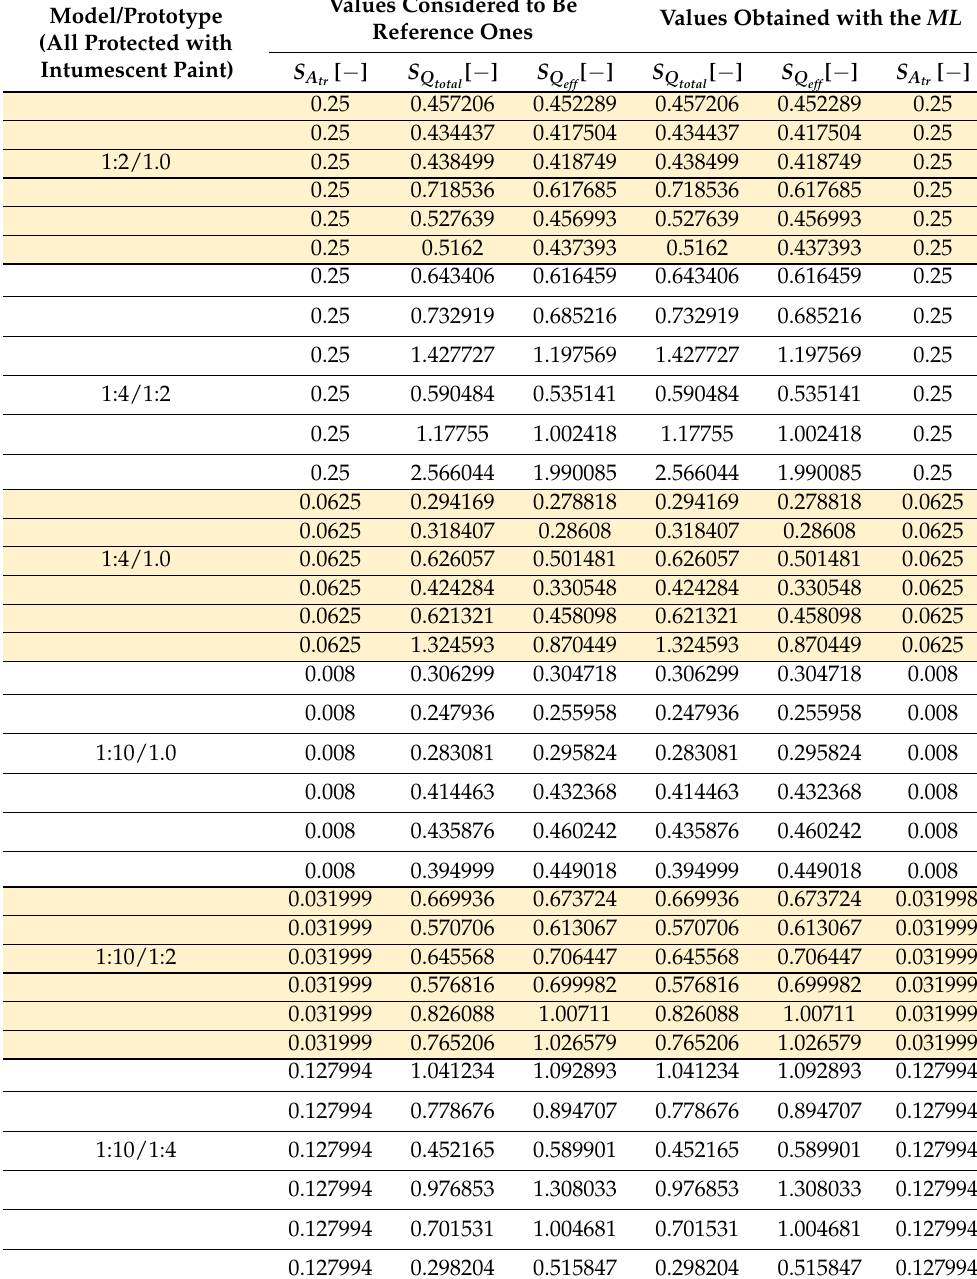
Table 7. Version II. The obtained values using